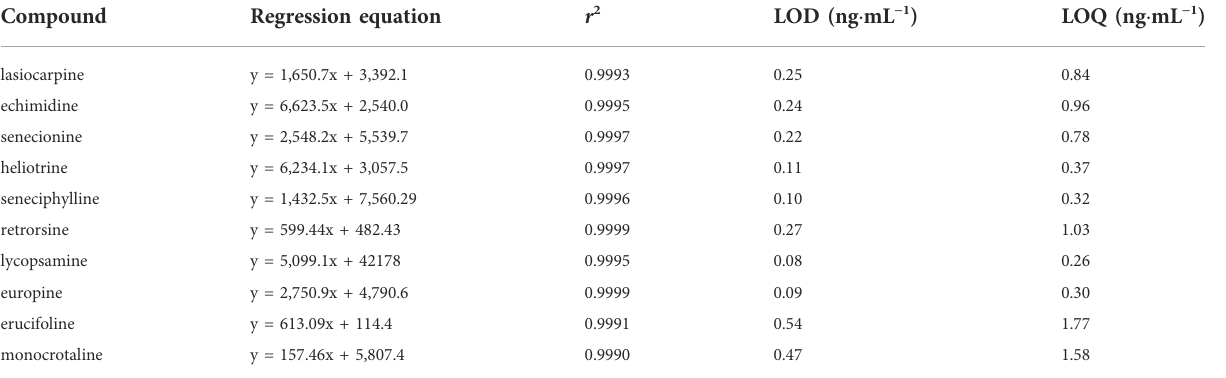
TABLE 4 Analytical parameters of the proposed method. Compound Regression